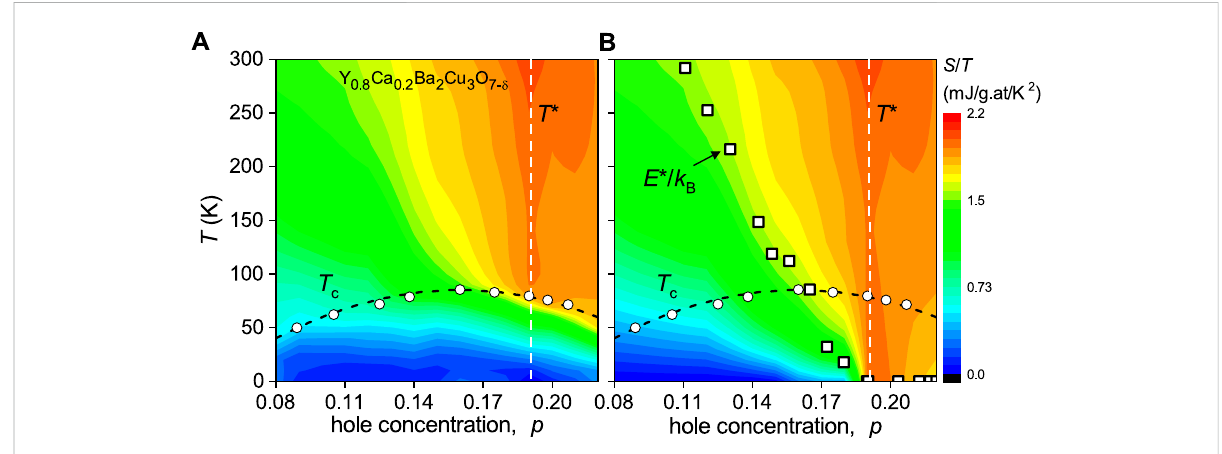
FIGURE 12 False-color mapsinthe p - T planeof S / T forY 0.8 Ca 0.2 Ba 2 Cu 3 O 7 − δ (A) asmeasured,includingthesuperconductingandnormalstates,and (B) for the normal state only if superconductivity were suppressed. The latter is determined using the equal-area entropy-balance method as illustrated in Figure1 (A) .Thesquaredatapointsin (B) arethepseudogapenergyasdeterminedfromthe y